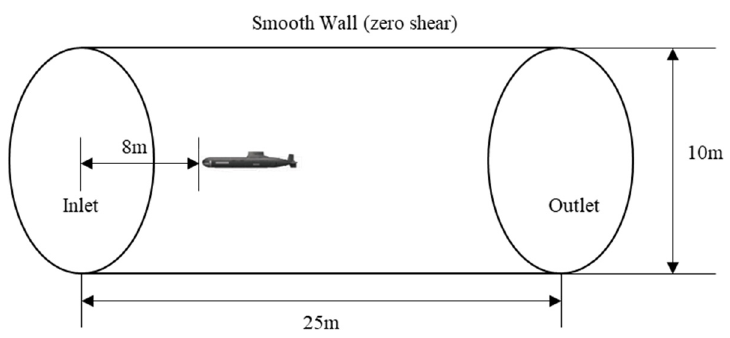
Figure 2. Computational domain and boundary conditions.